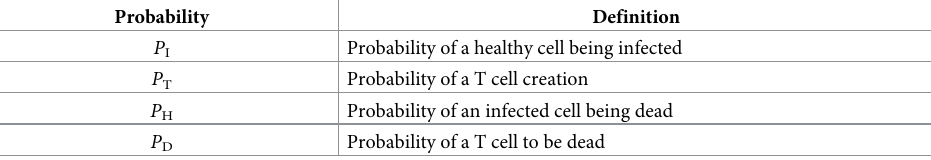
Table 1. The probabilities